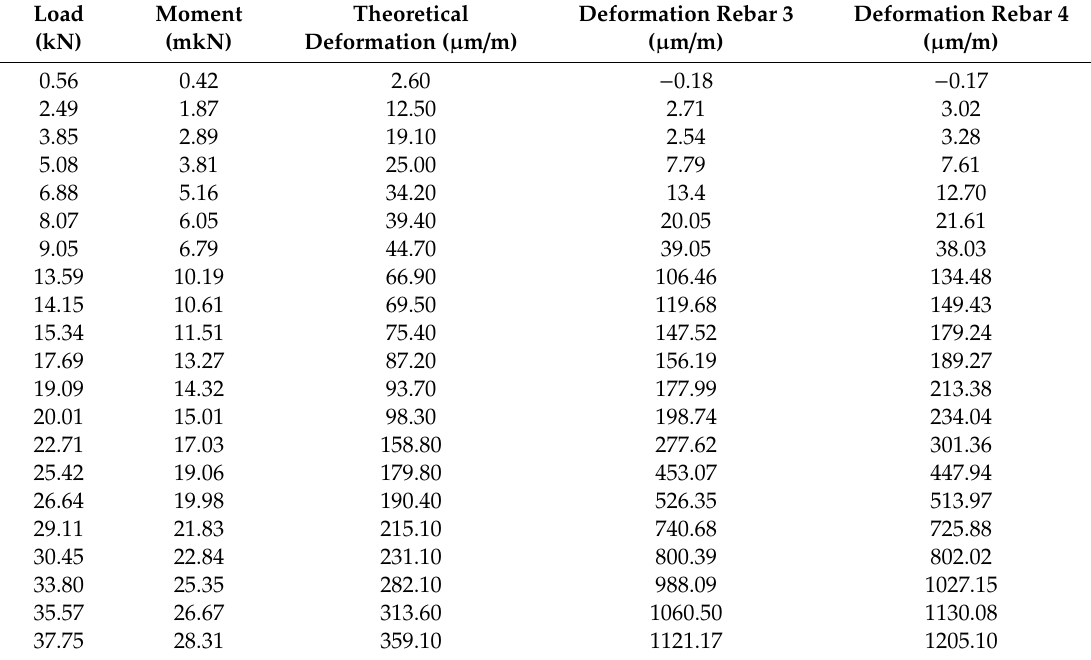
Table 3. Theoretical deformation of the rebars 3 and 4 for M fis = 16.2 mkN and f ct = 5.4 MPa with